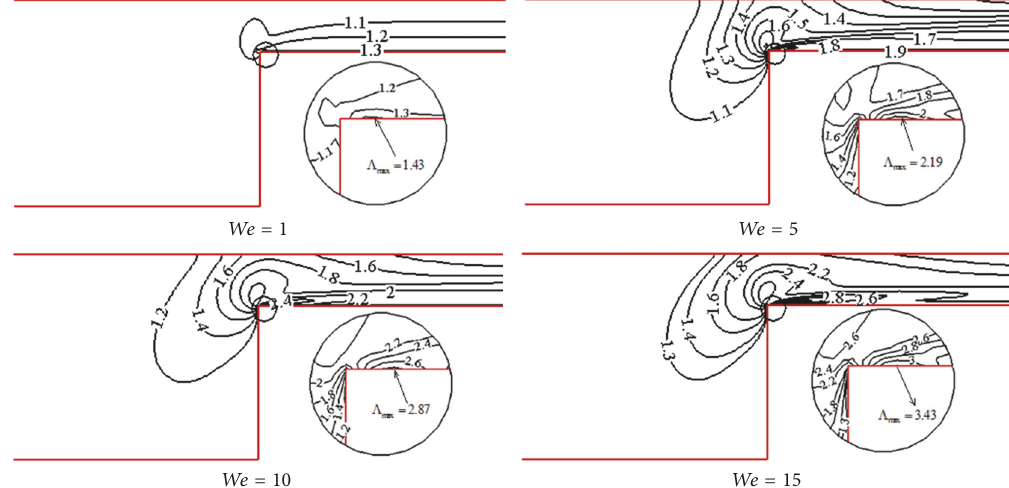
Figure 7: Backbone stretch (Λ) contours for different We